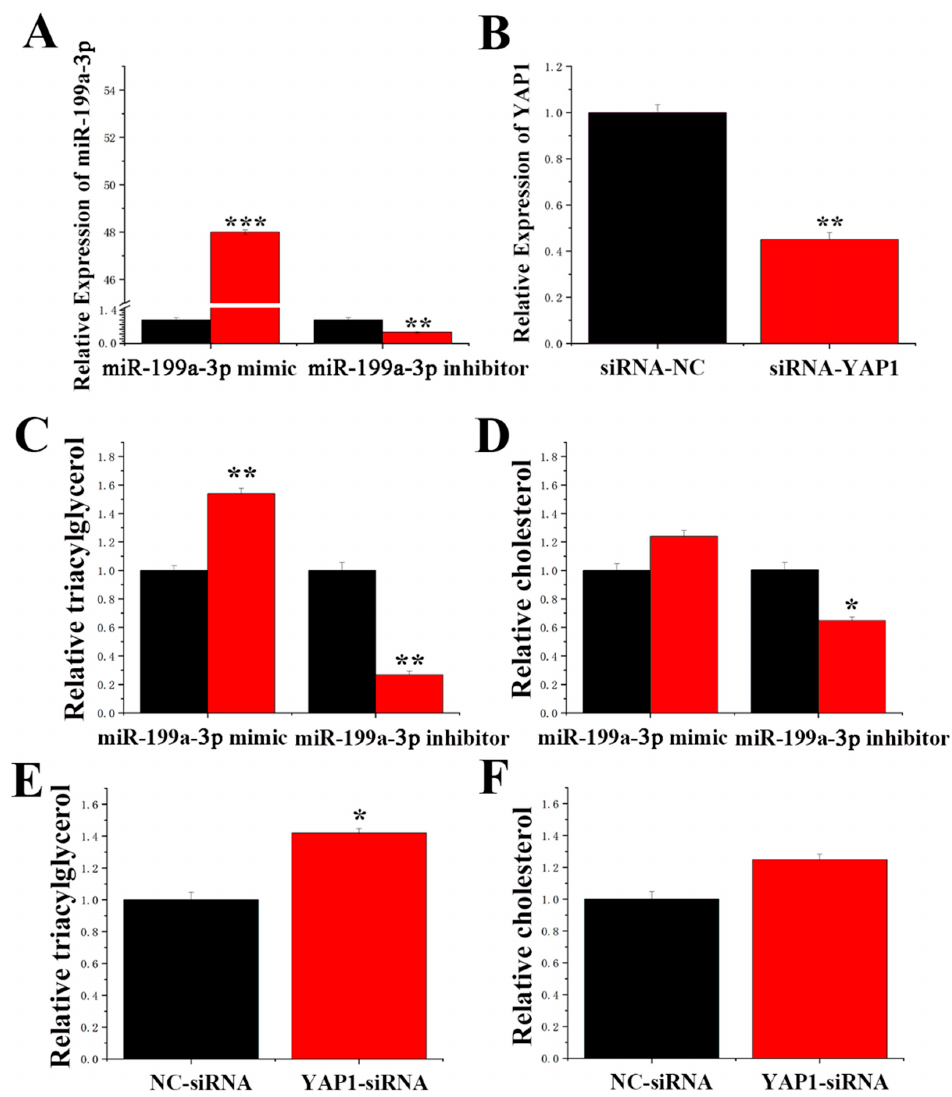
Figure 9. Functional evaluation of miR-199a-3p and YAP1 . ( A ) Expression levels of miR-199a-3p. Black bars represent the negative control, and red bars represent the miR-199a-3p mimic or inhibitor. ( B ) mRNA expression levels of YAP1 . ( C ) Relative TAG levels. ( D ) Relative cholesterol levels. Black bars represent the negative control, and red bars represent the miR-199a-3p mimic or inhibitor. ( E ) Relative TAG levels. ( F ) Relative cholesterol levels. Black bars represent the negative control, and red bars represent siRNA- YAP1 . Values are shown as the means ± standard errors, * p < 0.05; ** p < 0.01; *** p <